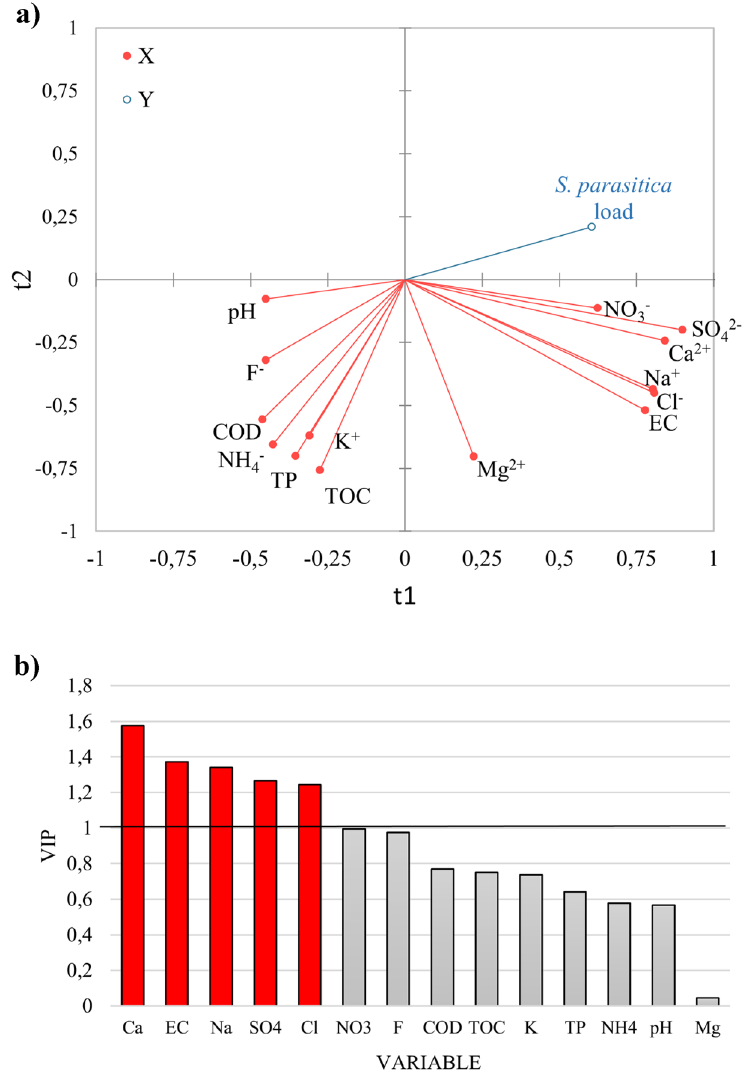
Figure 4. ( a ) Correlation radar describing the relationship between S. parasitica load (response variable, Y, blue line) and the physico-chemical parameters of the water (explanatory variables, X, red lines). The percentages of variances in X and Y explained by each variable are indicated on the respective axes. ( b ) The variable importance in projection (VIPs) for explanatory variables of the first component (t1). VIPs > 1 indicate the explanatory variables that contribute most to the PLS model, while VIPs < 0.8 contribute